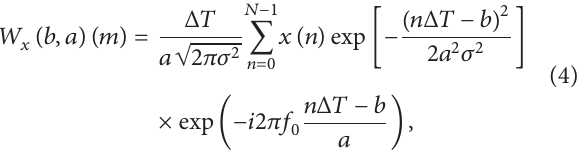
For time-discrete signa 𝑥(𝑡), 𝑡 = 𝑛Δ𝑇, 𝑛 = 1, 2, . . . , 𝑁−1